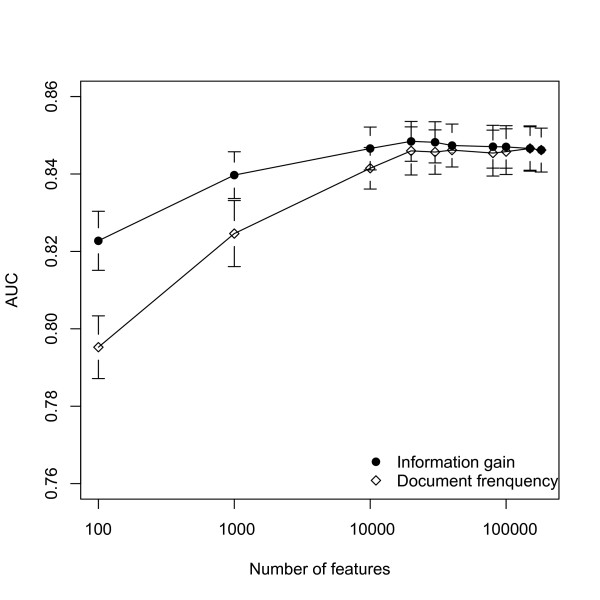
Effects of feature selection on Naïve Bayes classifier performance. The performances of the Naïve Bayes classifier (measured in AUC) is plotted against the number of features used in training. Both IG (information gain) and DF (document frequency) based feature selection have a similar effect on classifier performance. Reducing the number of features used to the top 20,000 by each measure leads to a small increase in performance. Using even less features leads to decreases in performance, but notably the top 100 features in term of information gain are sufficient to reach AUC values of 0.82.